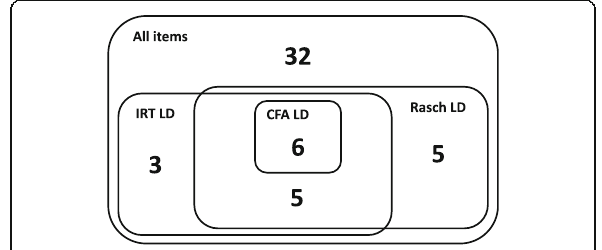
Fig. 4 Results from test of local item dependence (LD) using confirmatory factor analysis (CFA), item response theory analyses (IRT) and Rasch